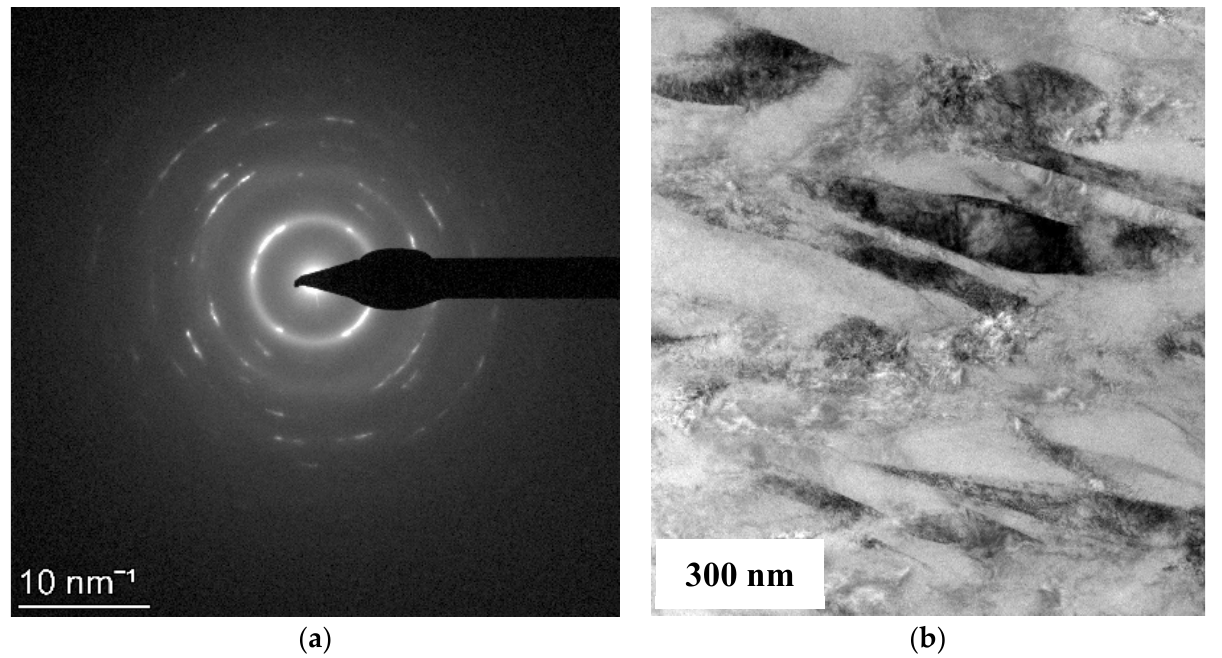
Figure 7. ( a ) Selected area diffraction pattern of Nitinol peened at 7 GW/cm 2 ; ( b ) bright field TEM micrograph of Nitinol peened at 7 GW/cm 2 showing a lamellar structure with high resolution. Also evident in these lamellae was the high amount of stored plastic deformation.